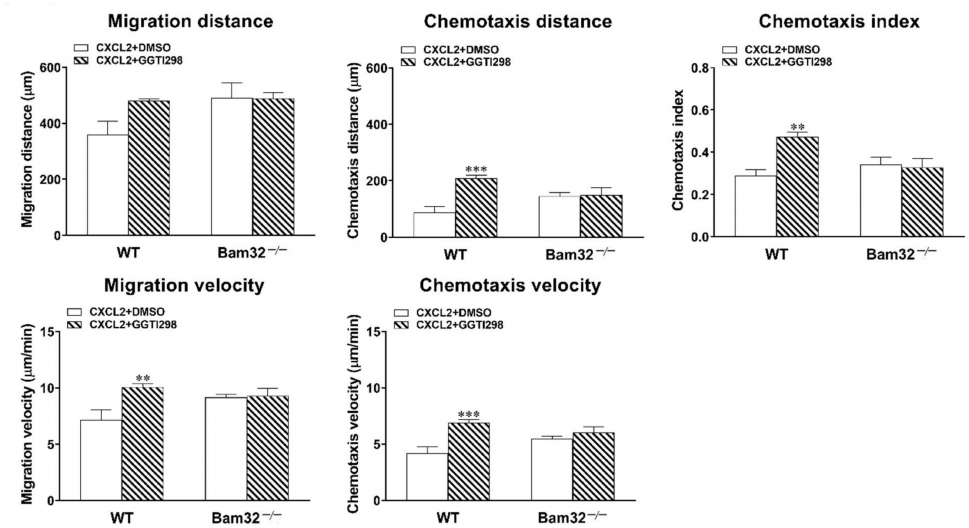
Figure 5. Effects of Rap1 inhibition on CXCL2-induced neutrophil chemotaxis in vitro. Data shown are the migration distance ( µ m), chemotaxis distance ( µ m), chemotaxis index, migration velocity ( µ m/min), and chemotaxis velocity ( µ m/min) for 60 min of neutrophils treated with DMSO (vehicle) or GGTI298 (10 µ M)—a geranylgeranyltransferase I inhibitor for blocking the processing of geranyl- geranylated Rap1—in 2D chemotaxis µ -slide (averaged from >50 cells). Mean ± SEM of 4 mice per group. ** and *** indicate significant differences ( p < 0.01 and p < 0.001, respectively) from the WT neutrophils with DMSO